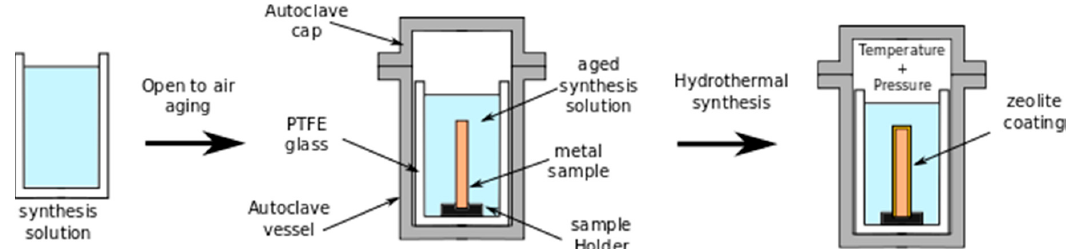
Figure 3. Scheme of hydrothermal synthesis process.